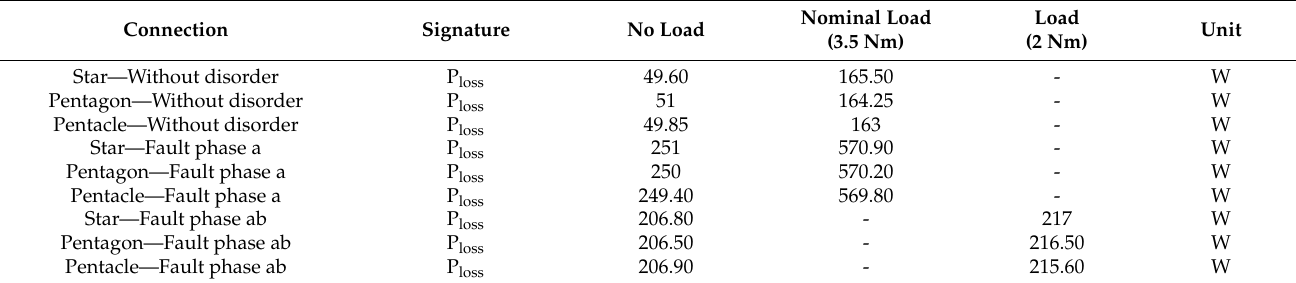
Figure 20. Magnetic stator flux, pentagram connection, without disorder. Table 2. Power losses for the same magnetic